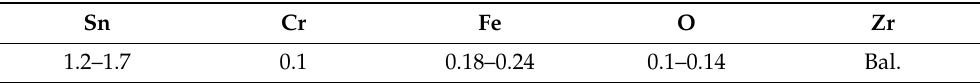
Table 1. Chemical composition (wt.%) of the Zircaloy-4 (Zy-4). Sn Cr Fe